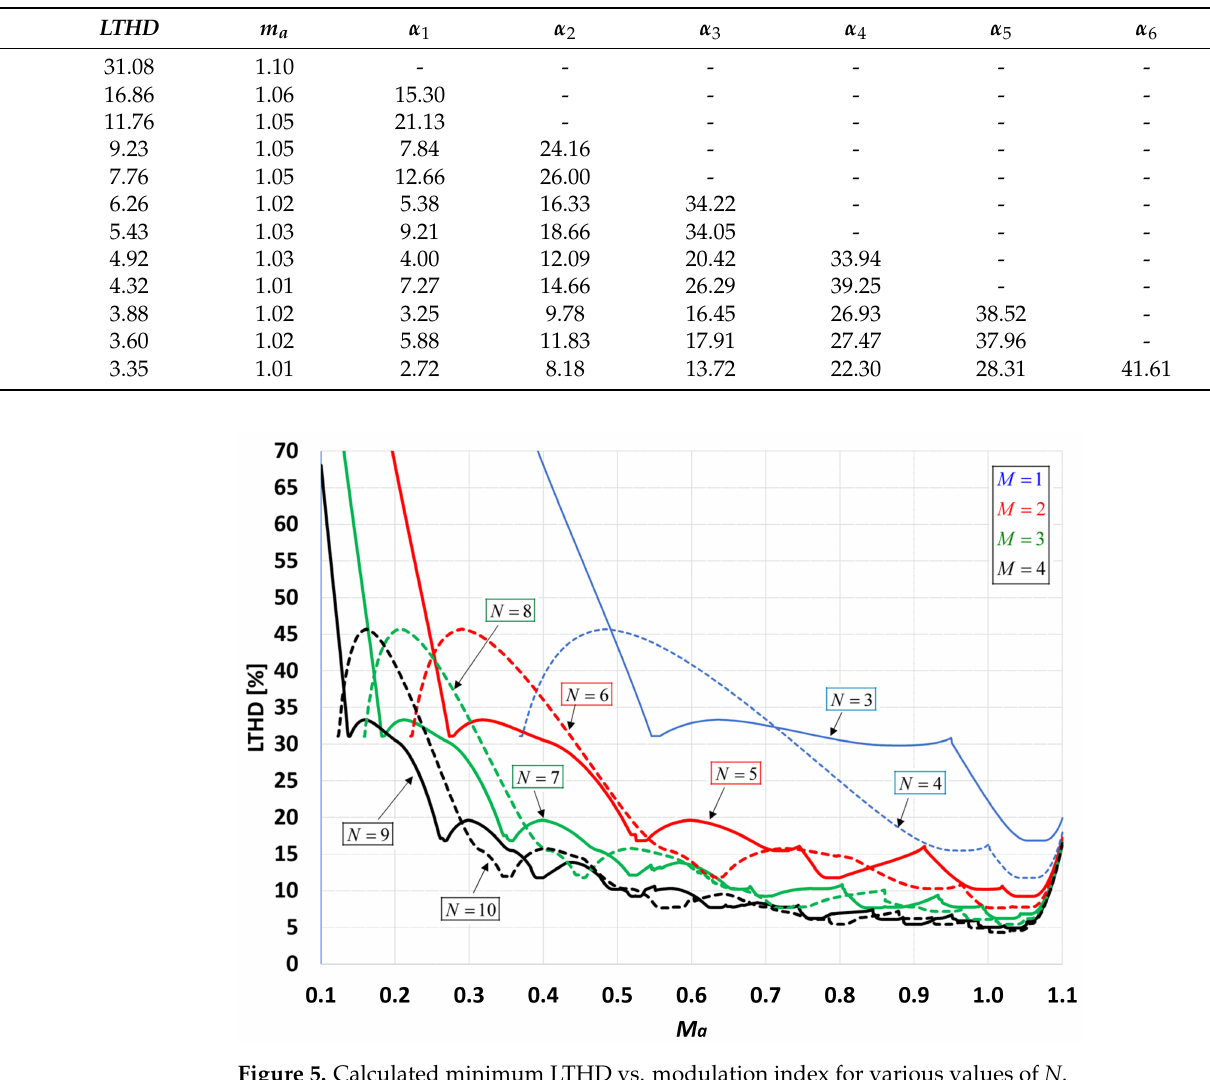
Figure 5. Calculated minimum LTHD vs. modulation index for various values of N .